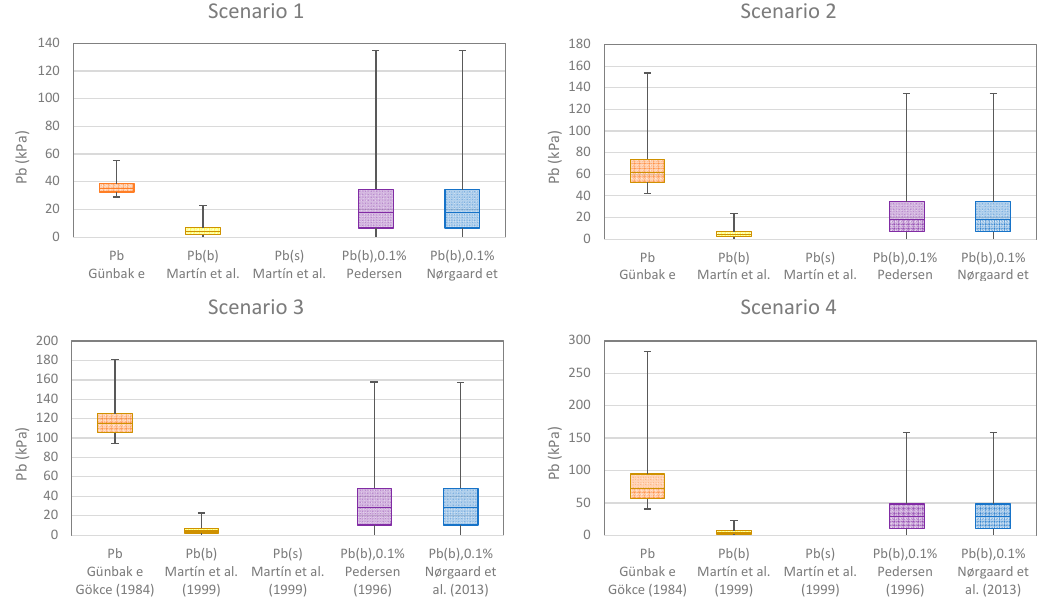
Figure 23. Results of Pb for the different formulas for Scenario 1 to 4.